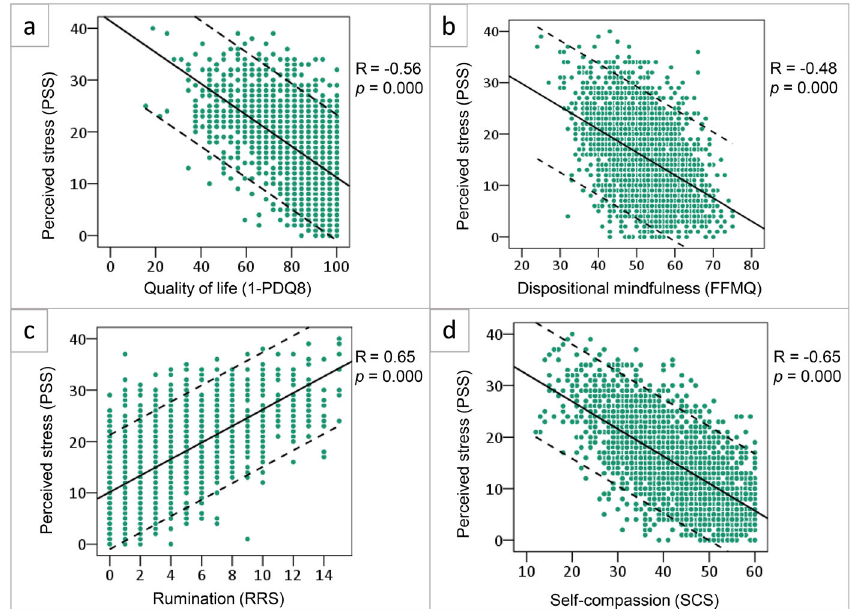
Fig. 1 Determinants of perceived stress in Parkinson ’ s disease. This fi gure shows the relation between perceived stress as measured by the Perceived stress Scale (PSS, on the y -axis) and a quality of life measured with the Parkinson ’ s Disease Questionnaire (PDQ-8), n = 3009; b dispositional mindfulness measured with the Five Facet Mindfulness Questionnaire (FFMQ), n = 2899; c rumination measured with the Ruminative Response Scale (RRS), n = 2899; and d self-compassion measured with the Self Compassion Scale (SCS), n = 2899 (all on the x -axis). For the PDQ-8, we have reversed the scores (1- score), such that for each of the variables shown a higher score means a higher subjective rating. For every plot, the Pearson correlation is shown with the associated 2-tailed signi fi